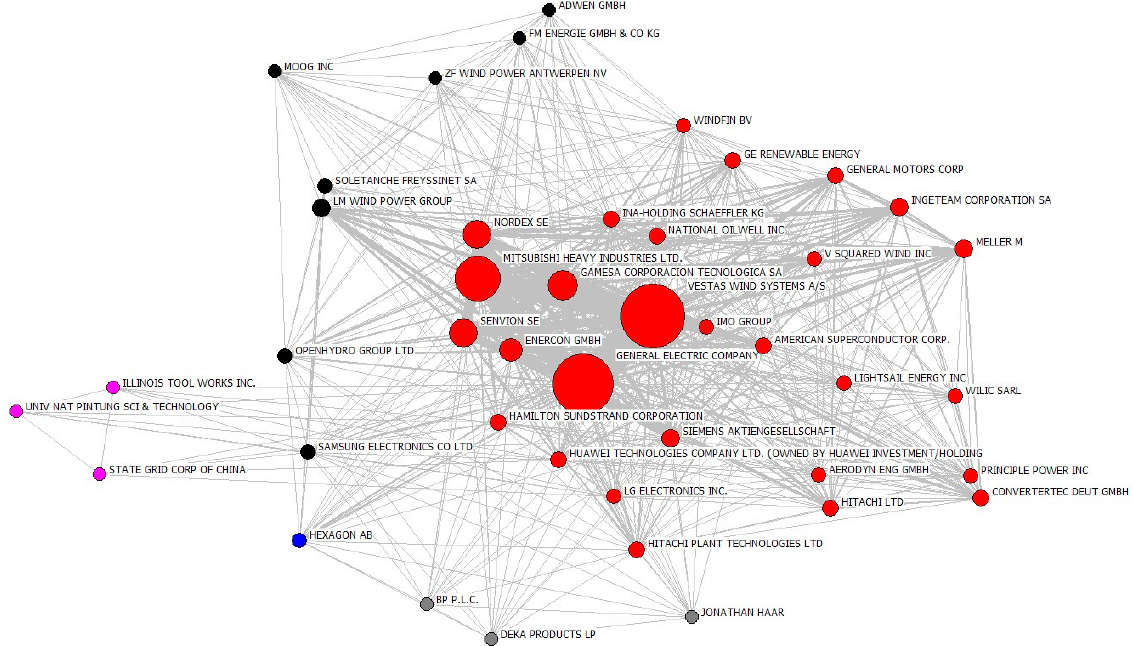
Figure 5. Firm competition network in 2010.